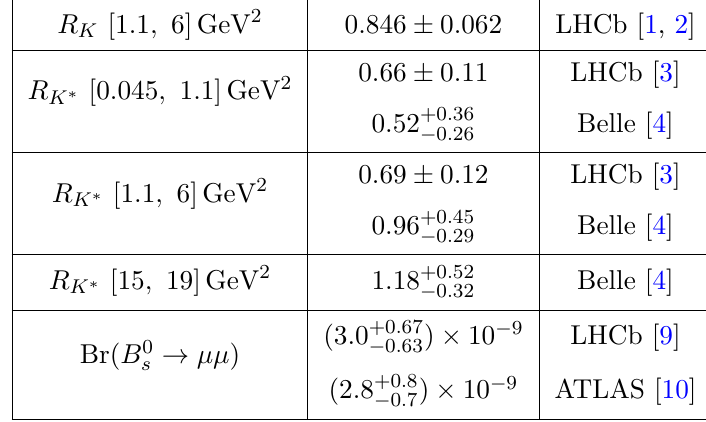
Table 1 . Clean observables sensitive to bs(cid:22)(cid:22) contact